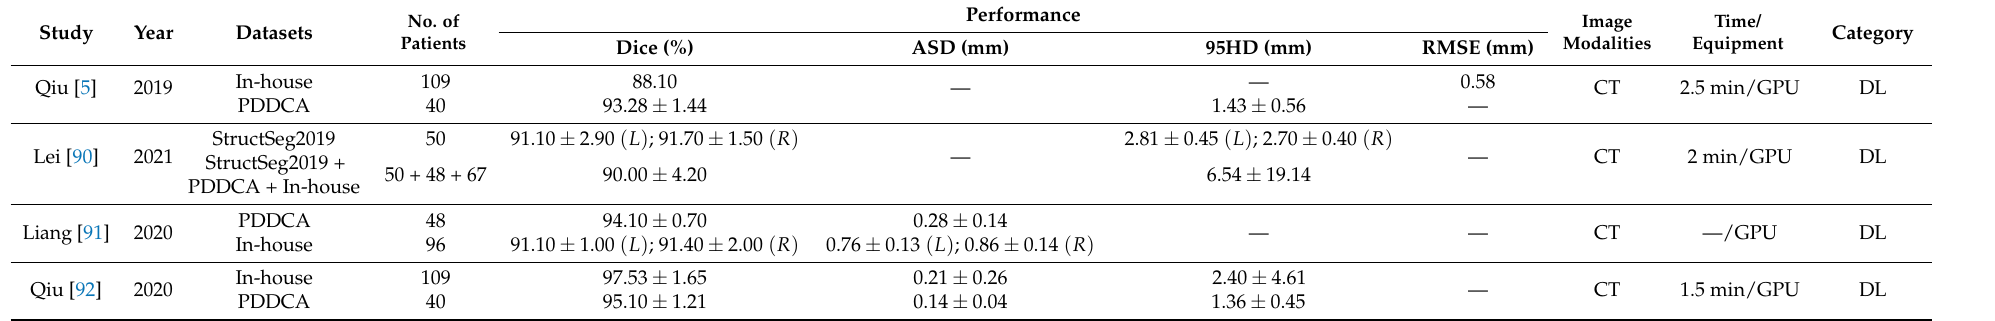
Table 9. Summary of 2.5D networks deep learning-based